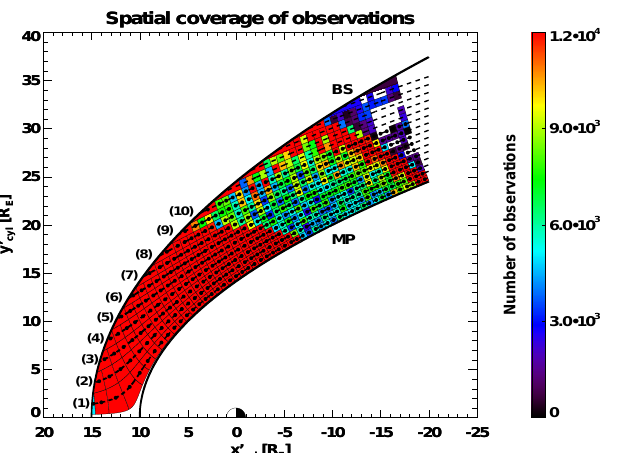
Fig. 8. Spatial coverage of magnetosheath observations displayed in Fig.